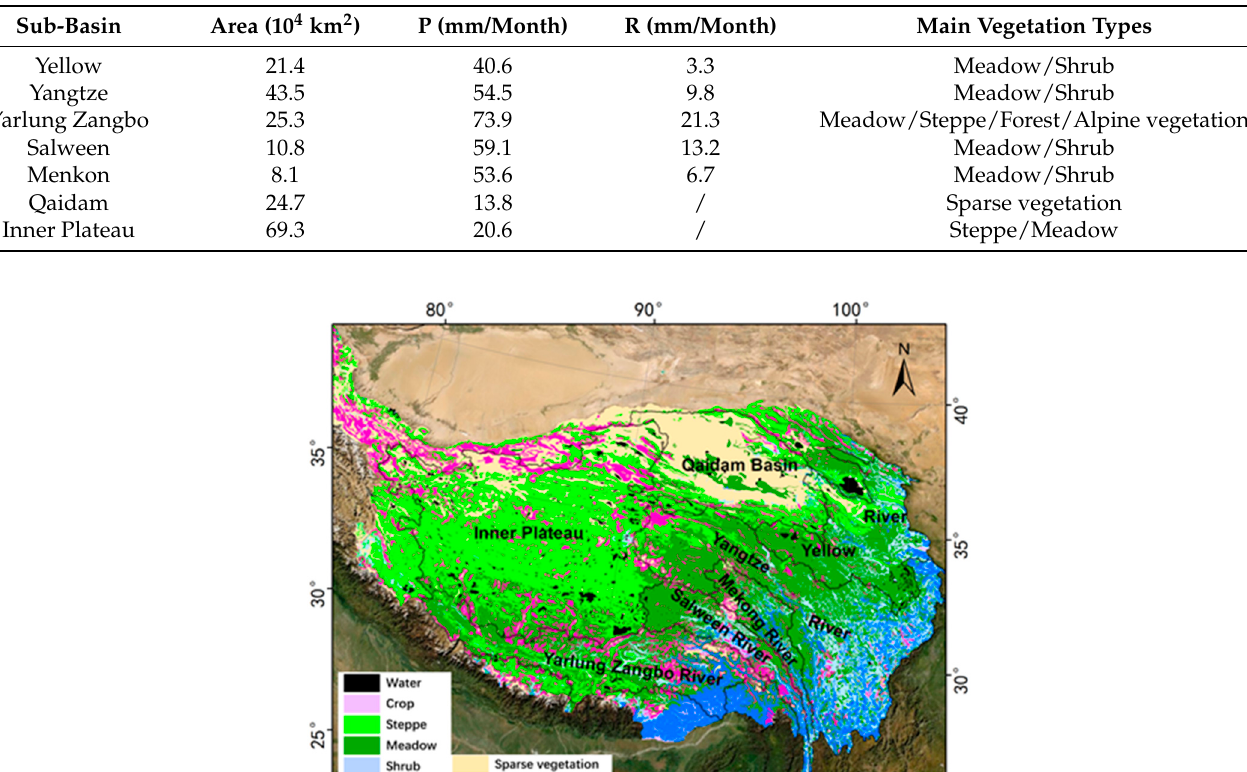
Figure 2. Distribution of vegetation types on the Tibetan Plateau (provided by http://westdc.west ‐ gis.ac.cn, accessed date: 01 July 2021).